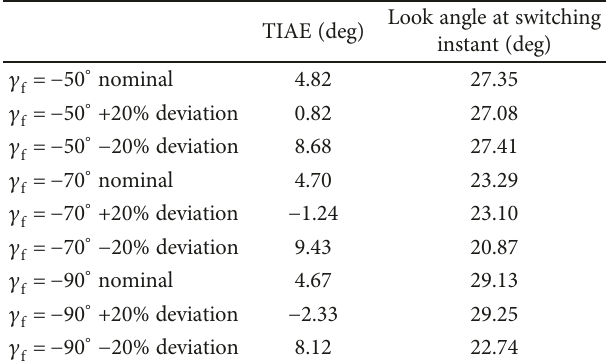
= 0 25 and γ = − 70 ° . m M f Table 3: Angle constraints of di ff erent